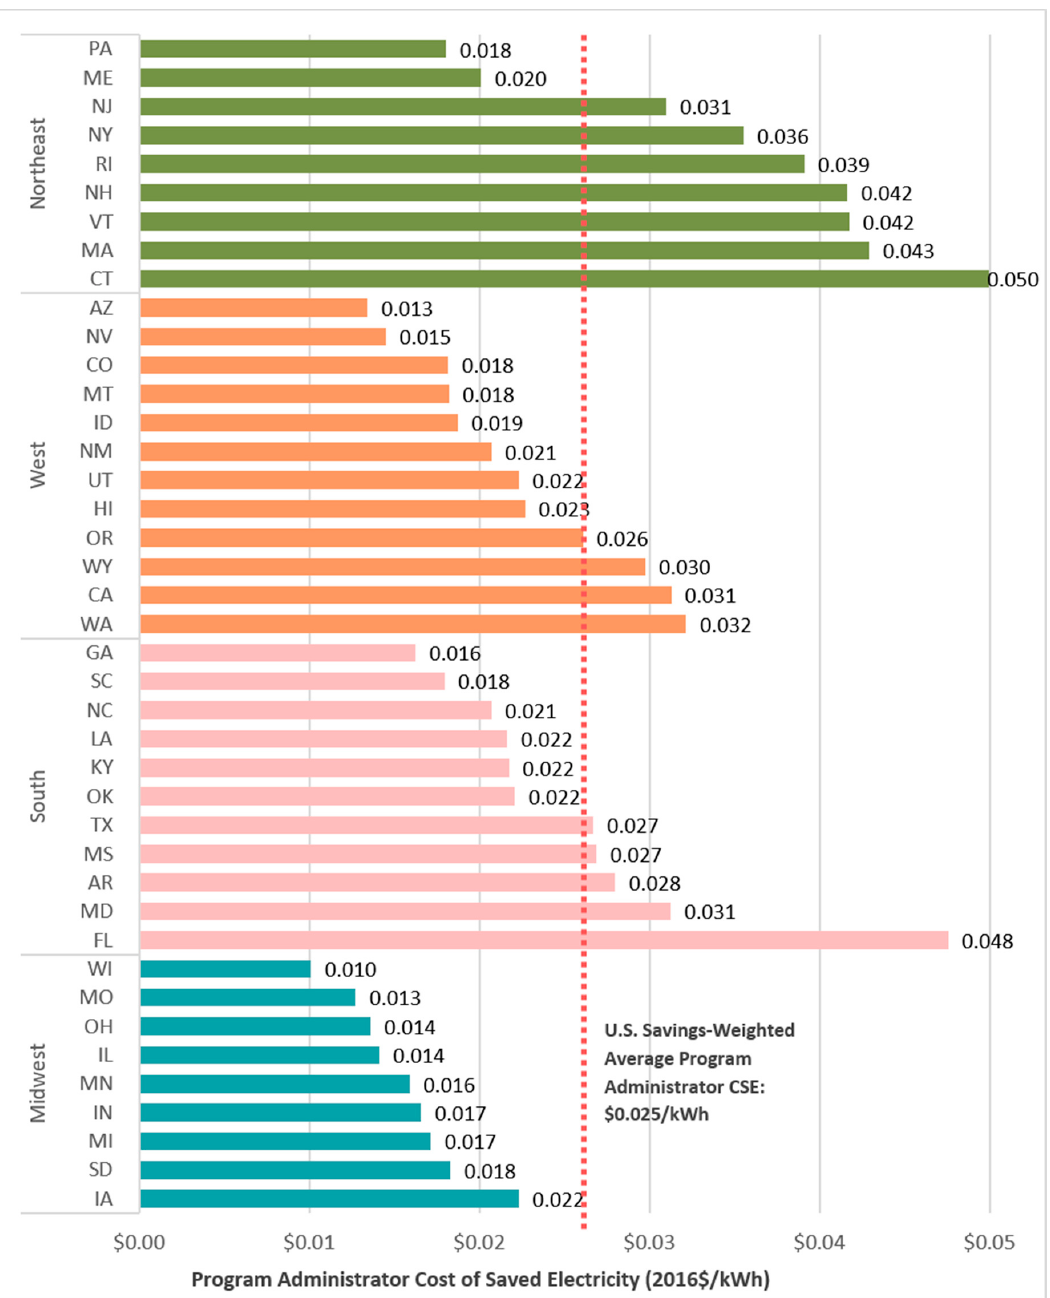
Figure 5. Program administrator CSE by state for 2009–2015: savings-weighted averages. 349 Five states had average PA CSE values that exceeded $0.04/kWh. Likely reasons include the 350 following. Four of the states are located in the Northeast (CT, VT, MA, NH) and had relatively high 351 electricity prices, extensive histories in pursuing energy savings, and strong policy commitments (e.g., 352 statutory mandates to acquire all cost-effective energy efficiency or meet specified savings targets). 353